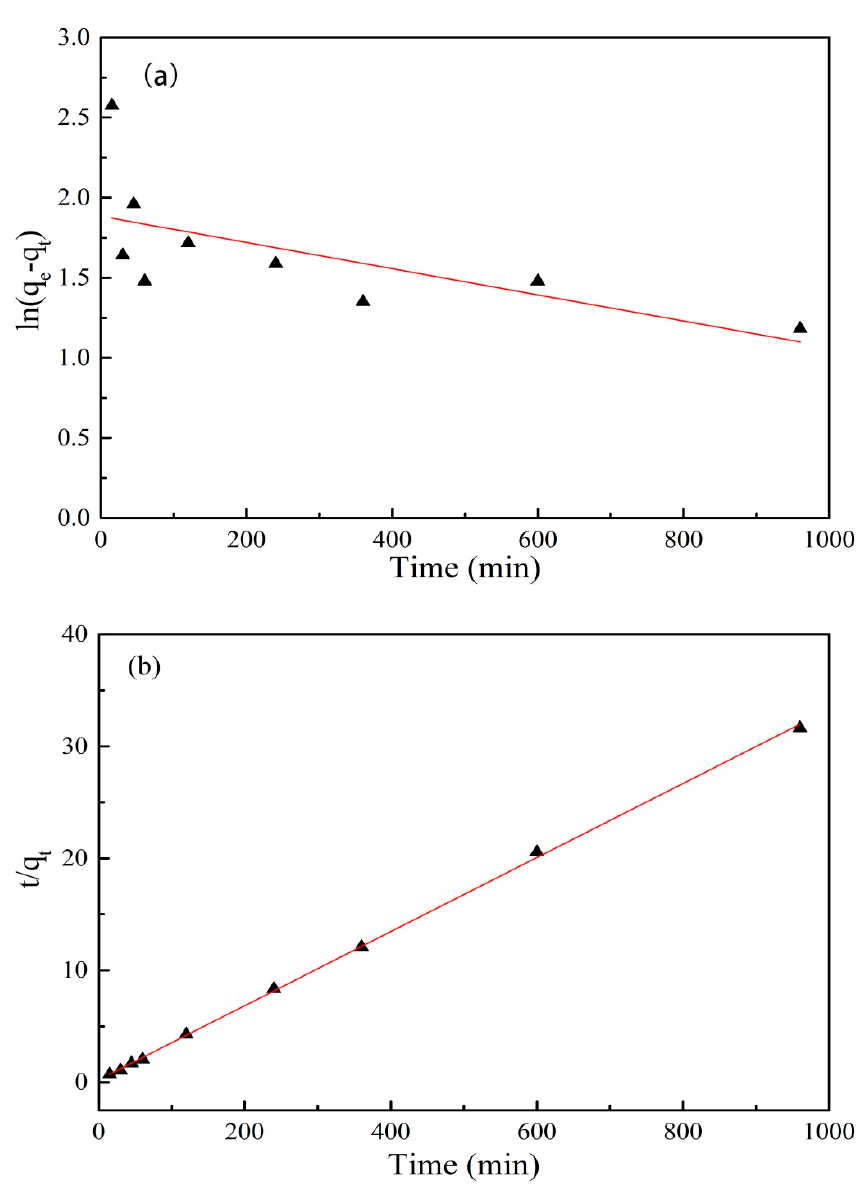
Figure 8. Adsorption kinetics curves of PRO onto GO/Fe 3 O 4 : ( a ) pseudo-first-order and ( b ) pseudo-second-order. Table 2. Kinetics parameters for the adsorption of PRO onto GO/Fe 3 O 4 .